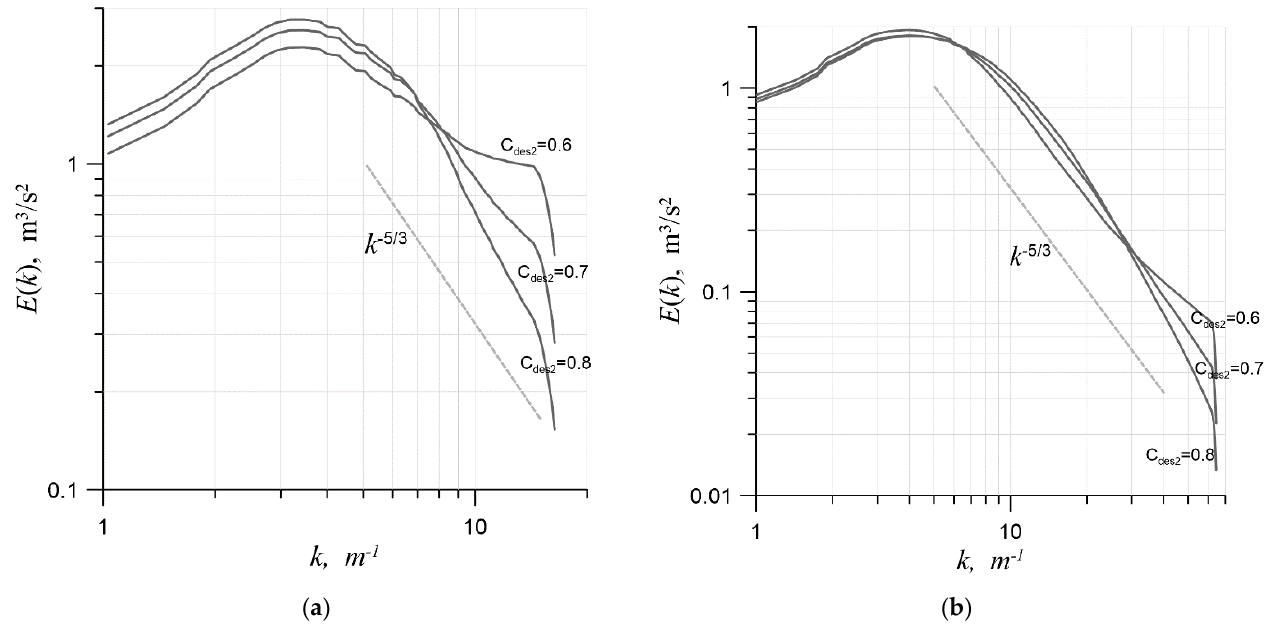
C values: ( a ) on a mesh with 32 3 cells and ( b ) on 2 DES